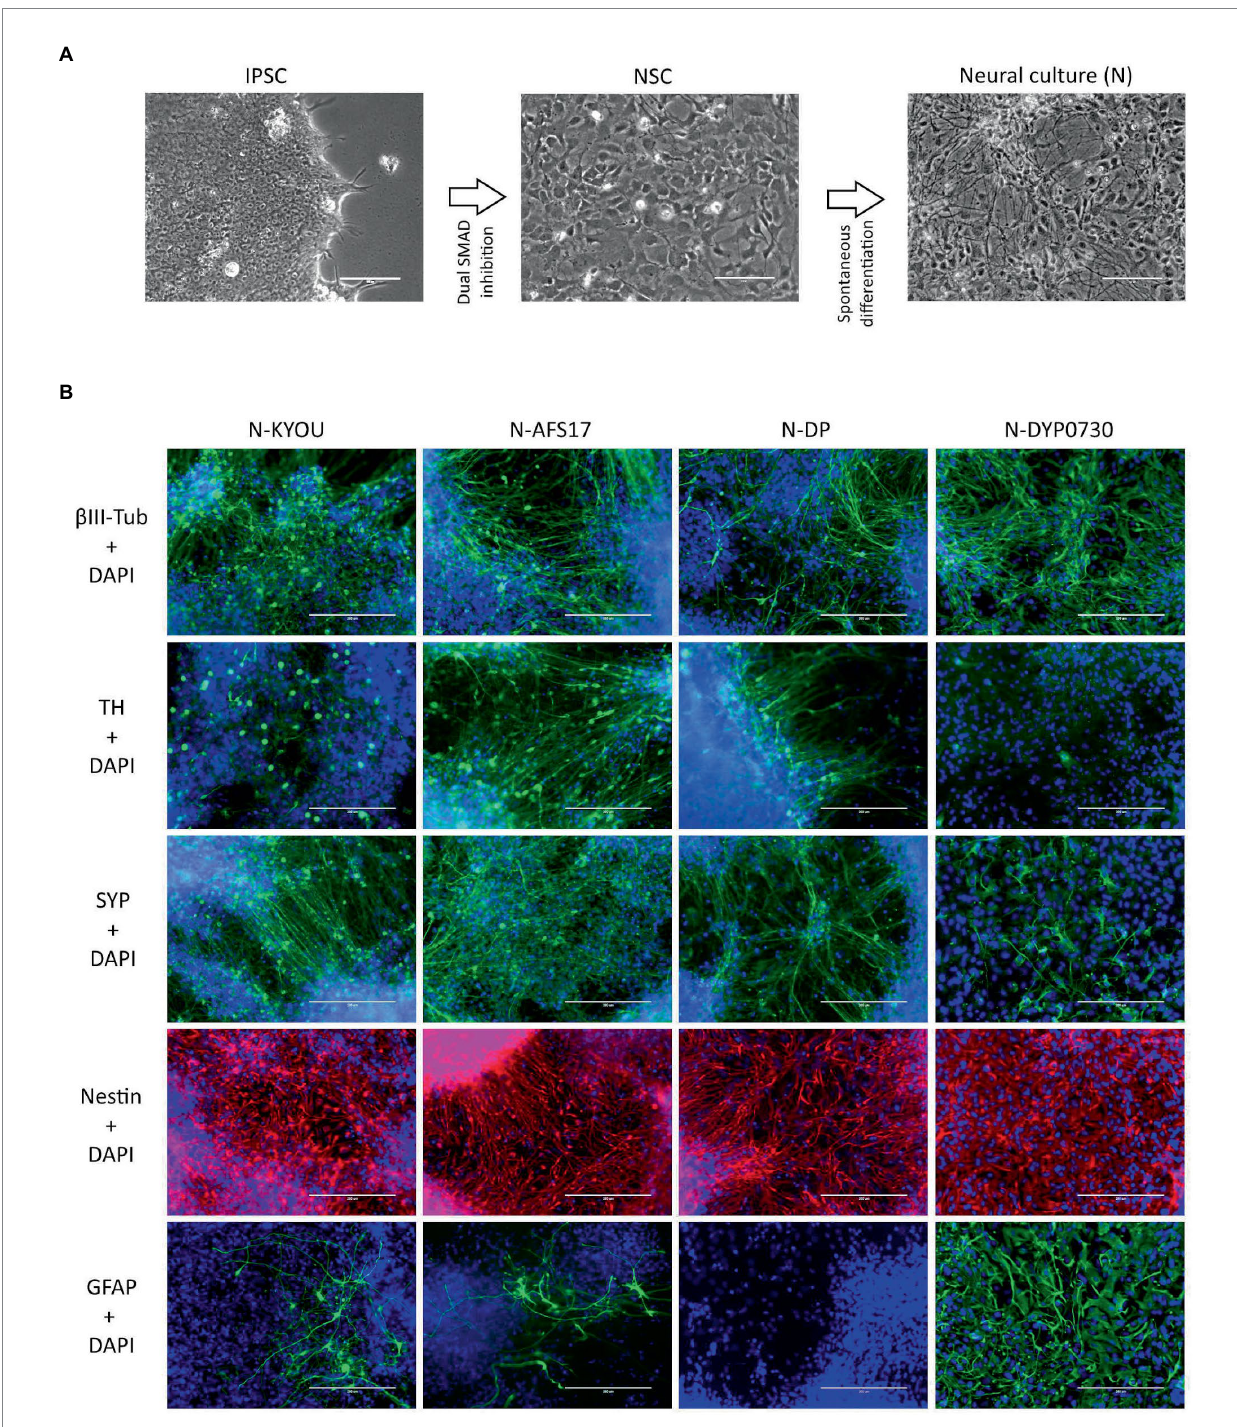
FIGURE 1 (A) Differentiation of IPSCs into neurons through the neural stem cell (NSC) stage using the DUAL SMAD inhibition protocol. IPSC–induced pluripotent stem cell; NSC–neural stem cell. Phase contrast microscopy, scale bar 200 μ m. (B) Immunocytochemical staining of neural cultures (N) at day 21 of spontaneous differentiation of different NSC lines (KYOU, AFS17, DP and DYP0730) at 5 passages. The cells were stained for neuron markers b-III- tubulin, tyrosine hydroxylase (TH) and synaptophysin (SYP), neuron precursor cell markers nestin and glial cell marker GFAP. Fluorescence microscopy, scale bar 200 μ